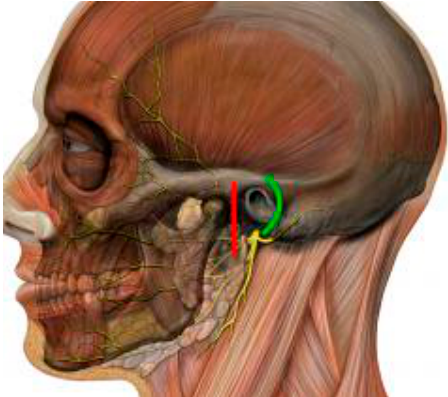
Figure 2. The course of the facial nerve branches in relation to the mandibular head. Retro- auricular (green line) and pre-auricular (red line) approaches. Modified from Patrick J. Lynch and C. Carl Jaffe: Head human skull lateral view, Head facial nerve superficial branches. 2006. https://creativecommons.org/licenses/by/2.5/.